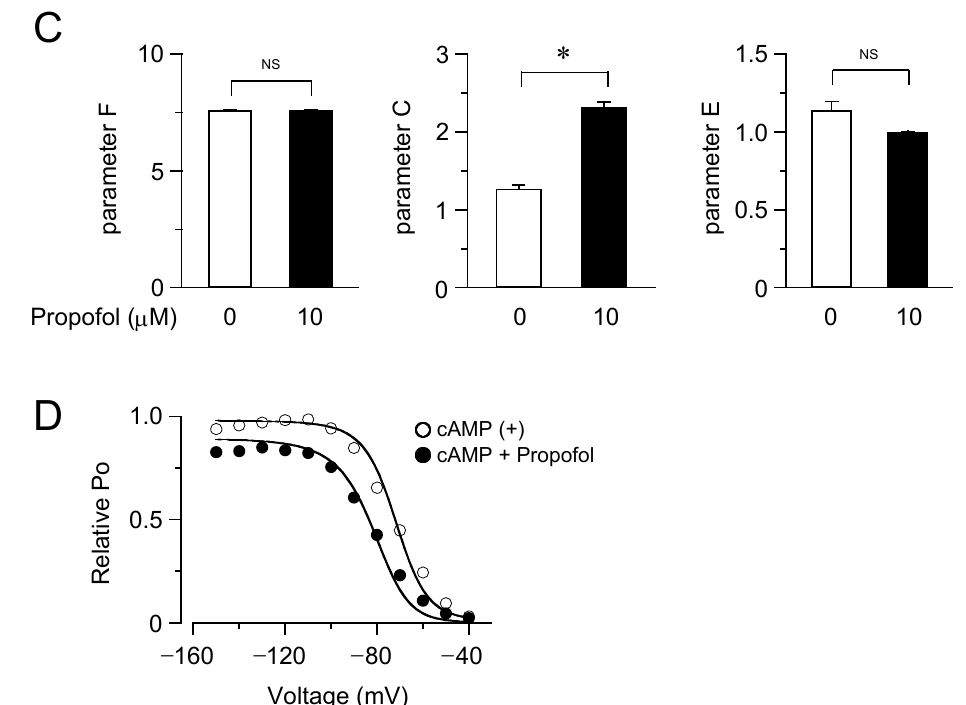
Figure 4. Allosteric gate model simulation of the inhibition of HCN4 channels by propofol. ( A ) The allosteric gate model for HCN channel activation, where L , H(V) , K are the equilibrium constants for the transitions between close and open (C–O) or rest and active (R–A) states in the PD, VSD, and CNBD, respectively. F , C, and E are the allosteric coupling factors between the PD and the VSD, between the PD and CNBD, and between the VSD and CNBD, respectively. ( B ) Model fitting to the P O - V data in the presence and absence (control) of propofol, obtained by normalizing the current density (relative P O ) to the maximum value in control. The best-fit parameters of F , C, and E are 8.2, 1.6, and 1.6, respectively, in controls, and became 7.8, 2.9, and 1.3, respectively, in the presence of propofol. ( C ) Parameters of model fitting to the P O - V data in the presence and absence (control) of propofol. Bars represent the mean ± S.E.M. ( n = 6). *, p < 0.05, NS, not significant. ( D ) Simulated P O - V curves with cAMP (50 µ M) as determined by the model with the same parameter sets used in ( B ), which closely overlay the experimental data points.